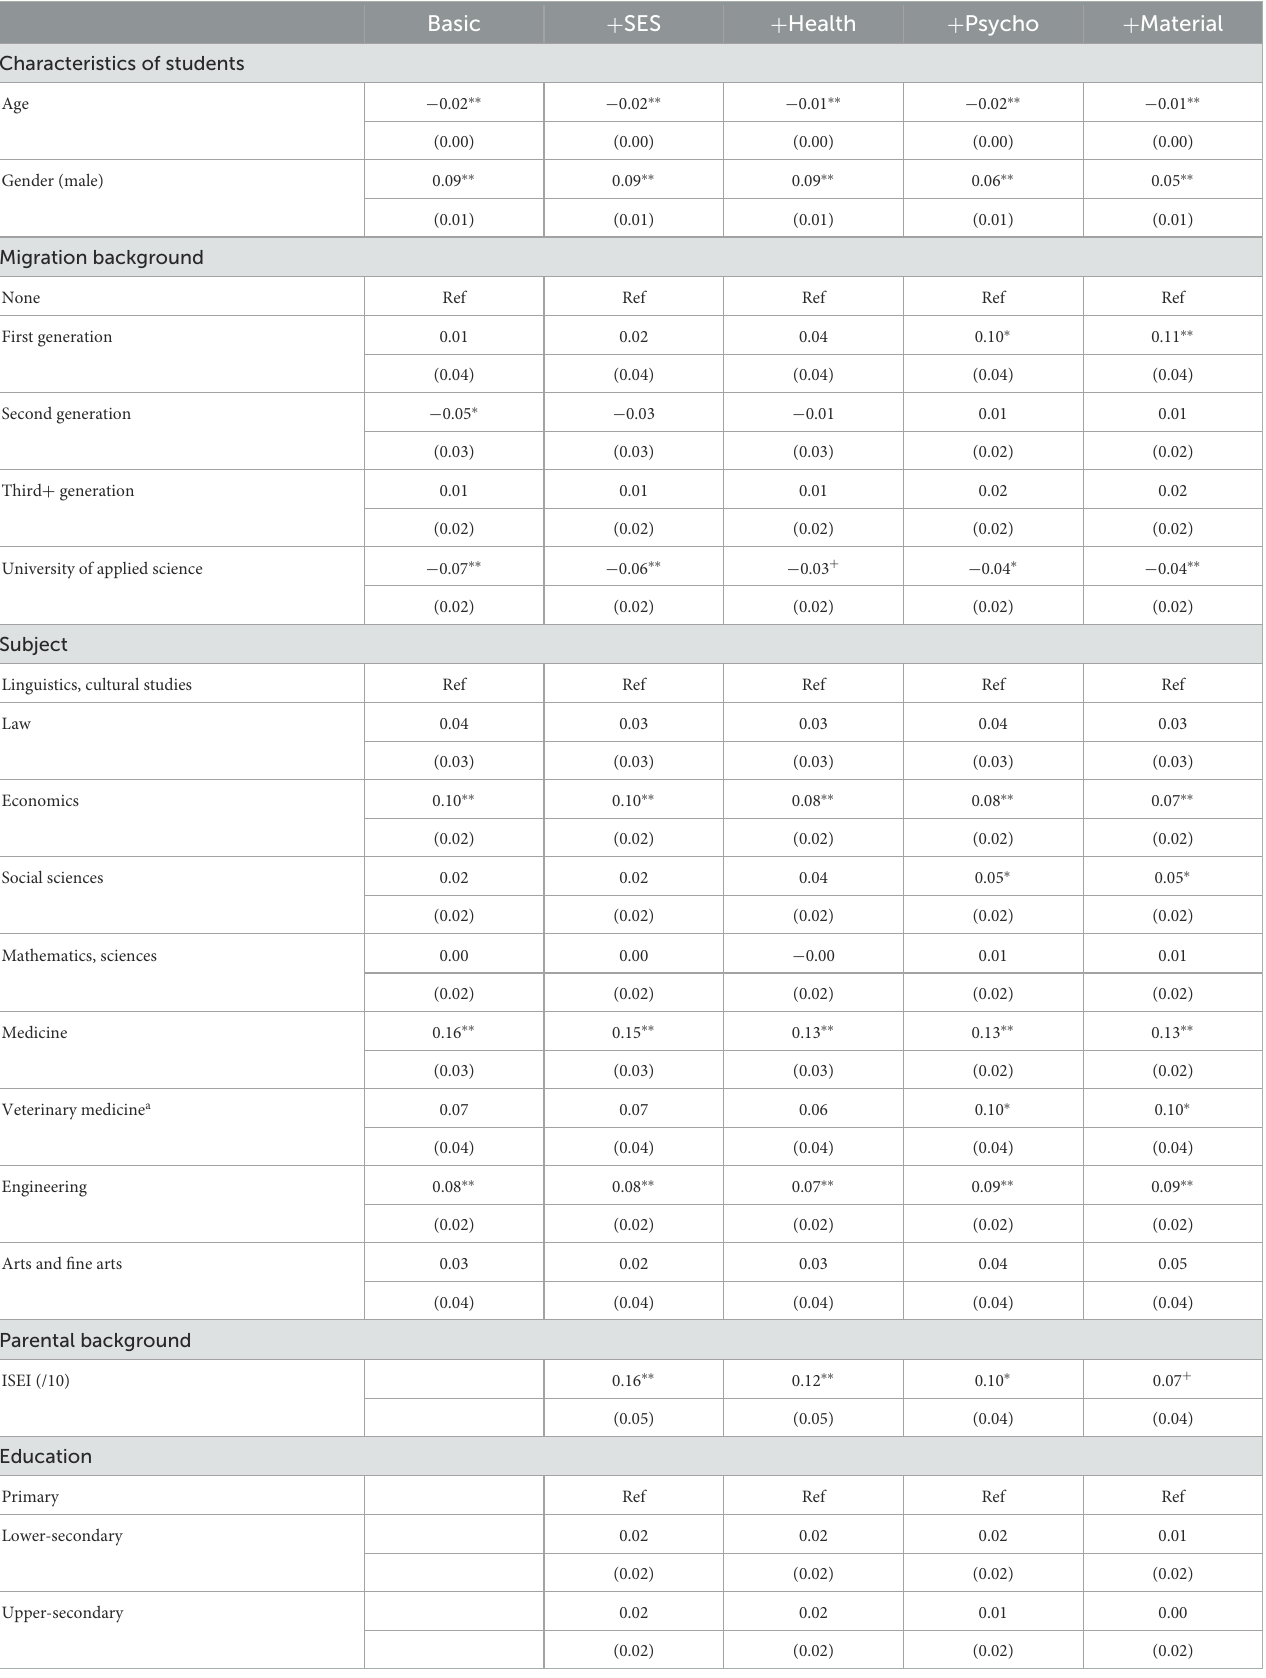
TABLE 3 Multilevel linear regression of students’ characteristics and their socio-economic background on their self-reported health status. Basic + SES + Health + Psycho +